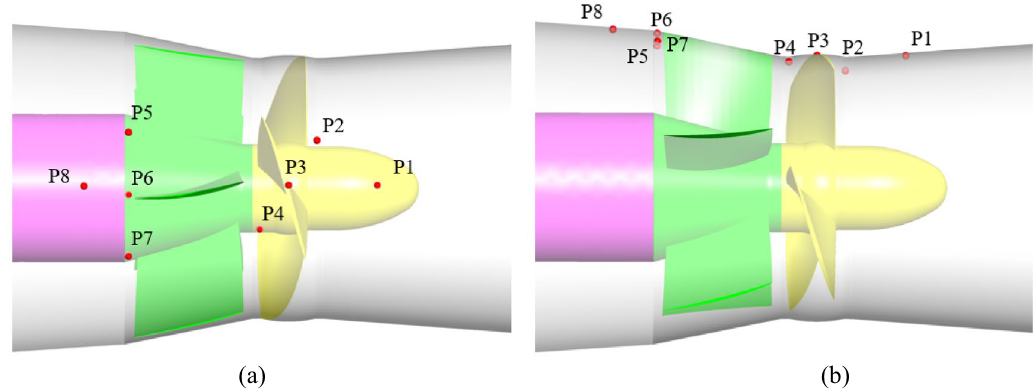
Figure 6. Schematic diagram of the specific locations of the monitoring points arranged in the